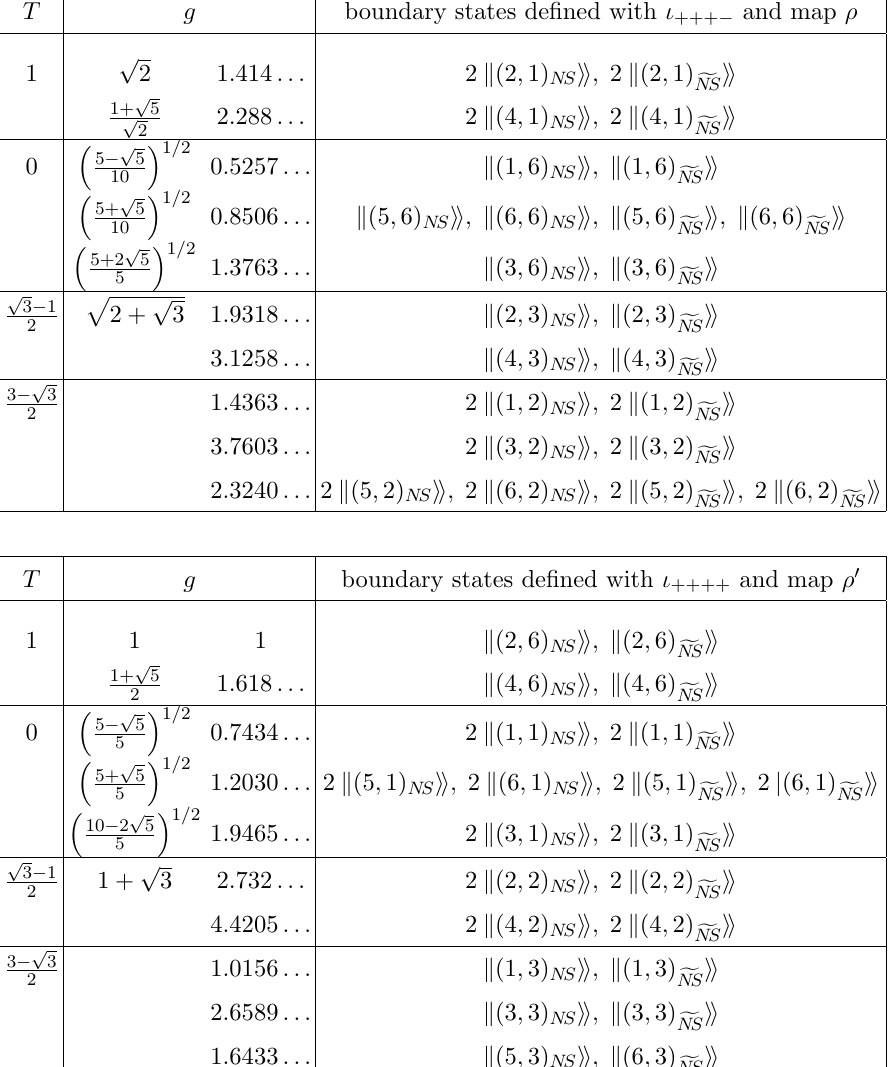
Table 5 . T and g values for the SVIR 3 (cid:10) 2 boundary